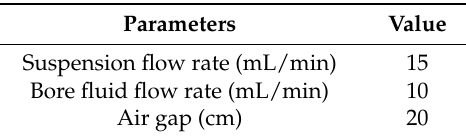
Table 1. The spinning parameters used in this